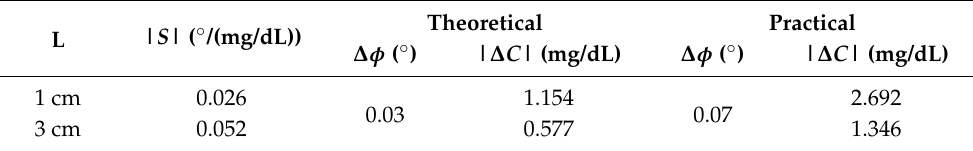
Table 1. The resolution of the proposed method with different sensor